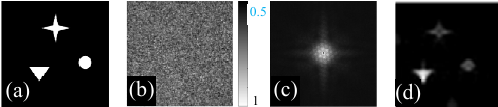
Fig. 5 Simulation result of imaging an icon through a 1-mm-thick layer of chicken breast tissue: (a) a photograph of the icon composed by three geometry structures, (b) and (c) speckle pattern and the amplitude of its Fourier transform, and (d) reconstructed image of the icon.